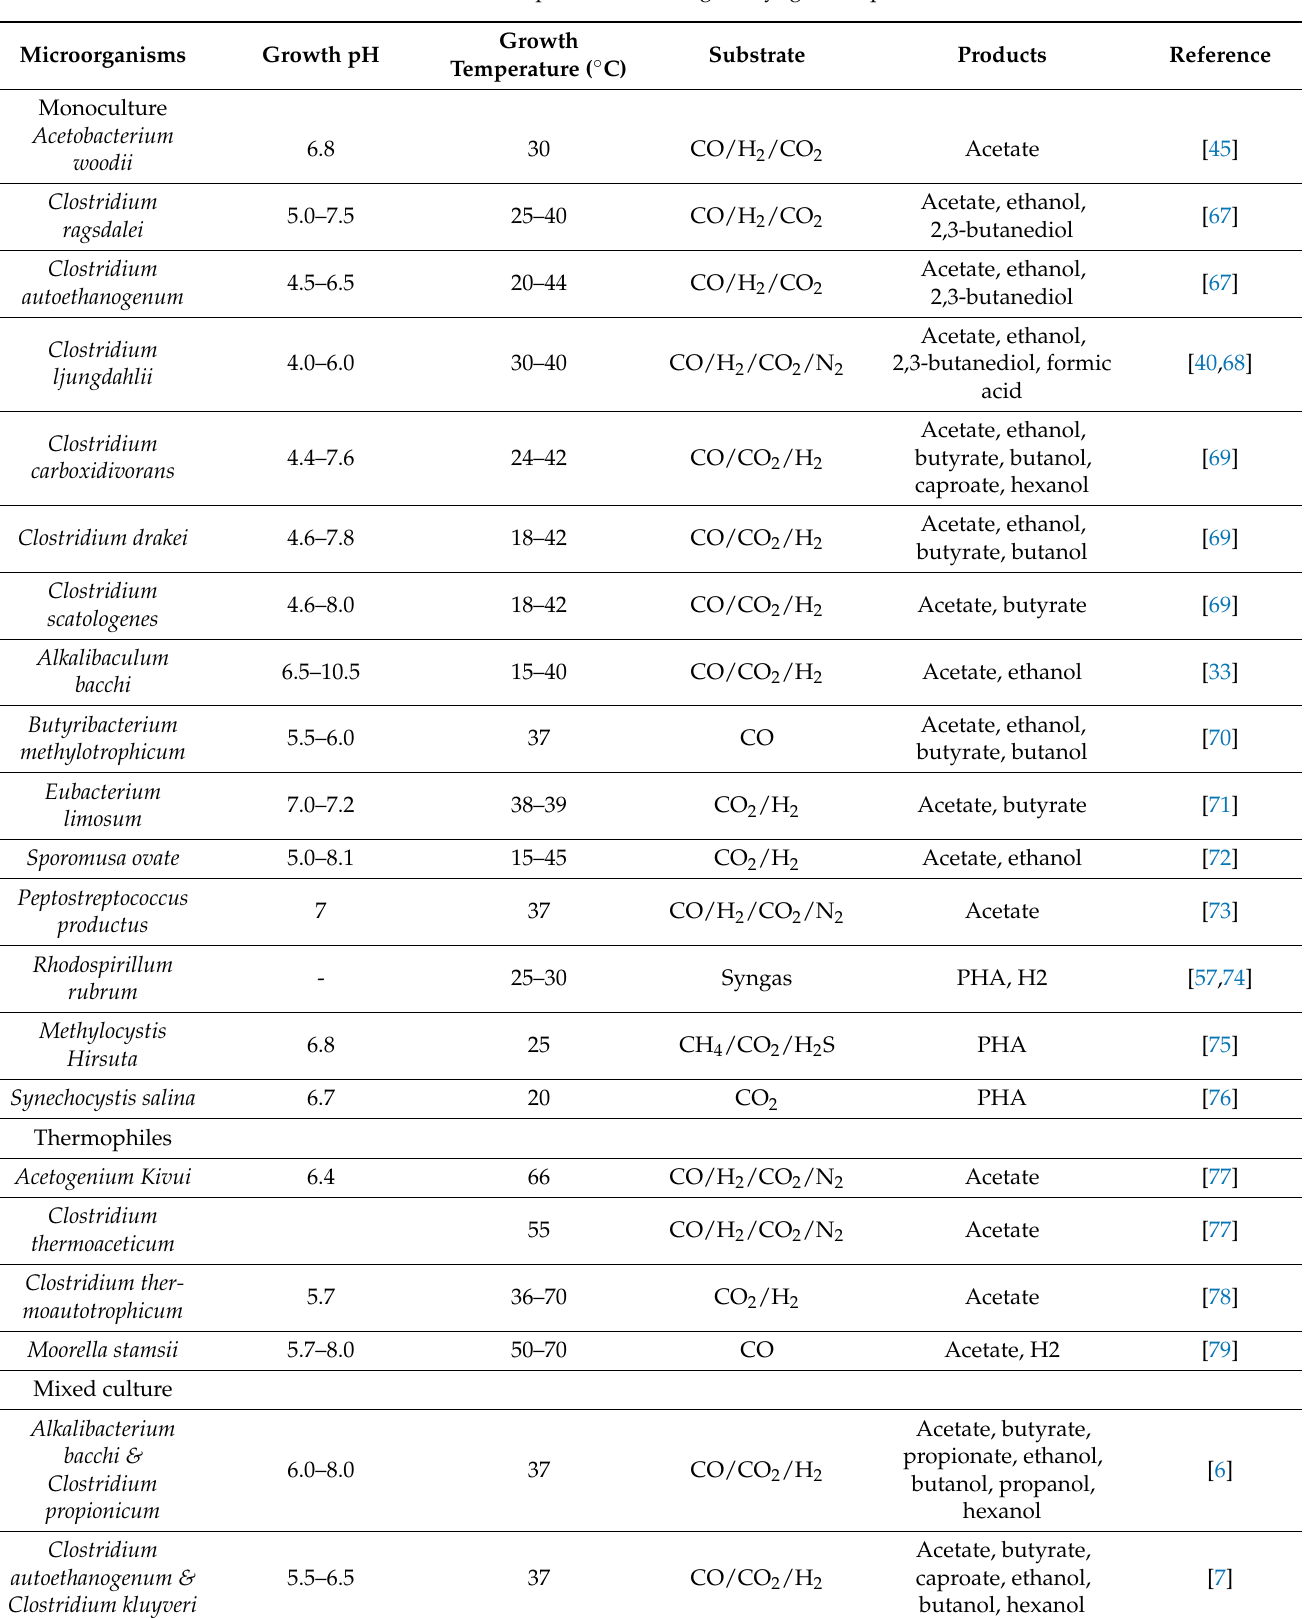
Table 2. Microbial species fermenting the syngas